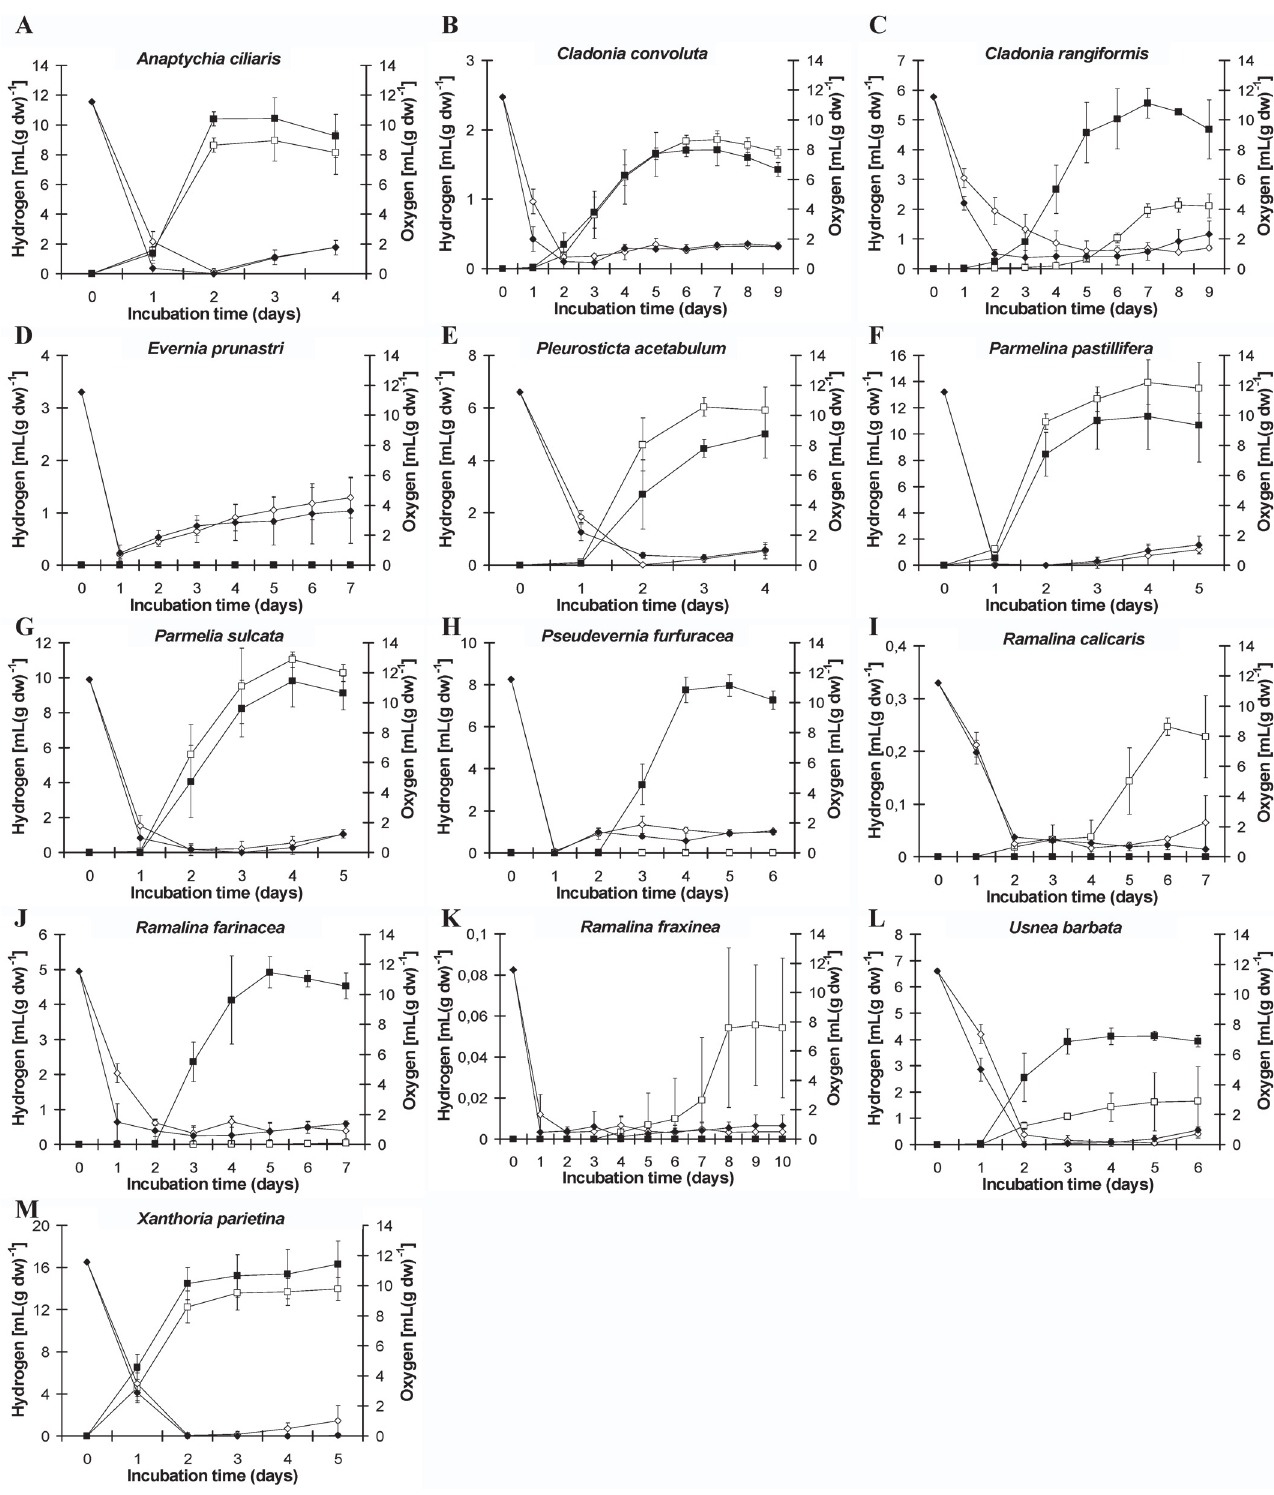
Fig 9. Kinetics of hydrogen production and oxygen consumption under light (white shapes) and dark incubation (black shapes) in (A) Anaptychia ciliaris , (B) Cladonia convolute , (C) Cladonia rangiformis , (D) Evernia prunastri , (E) Pleurosticta acetabulum , (F) Parmelina pastilifera , (G) Parmelia sulcata , (H) Pseudevernia furfuraceae , (I) Ramalina calicaris , (J) Ramalina farinacea , (K) Ramalina fraxinea , (L) Usnea barbata , (M) Xanthoria parietina .